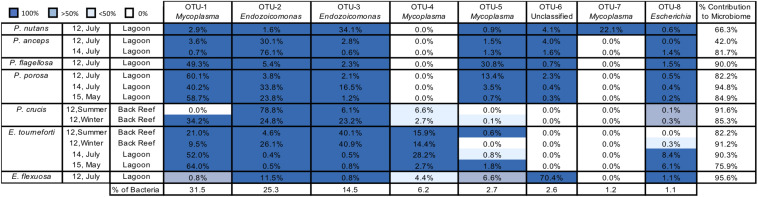
The most abundant bacterial Operational Taxonomic Units (OTUs) in seven Caribbean gorgonian species. Prominent bacterial OTUs (1–8) are listed to the lowest bacterial taxonomic level. OTU presence in gorgonian branches (0–100% of branches sampled) is depicted by different shades of blue. The mean contribution (% of sequences) of each OTU to the microbiome of a gorgonian species is listed in each cell, with the total contribution in the final column. The prevalence (%) of each bacterial OTU in the bacteria obtained from all the gorgonian species combined appears in the bottom row. The gorgonian species are Plexaurella nutans, Pterogorgia anceps, Pseudoplexaura flagellosa, Pseudoplexaura porosa, Pseudoplexaura crucis, Eunicea tourneforti, and Eunicea flexuosa; Summer = July, Winter = December.